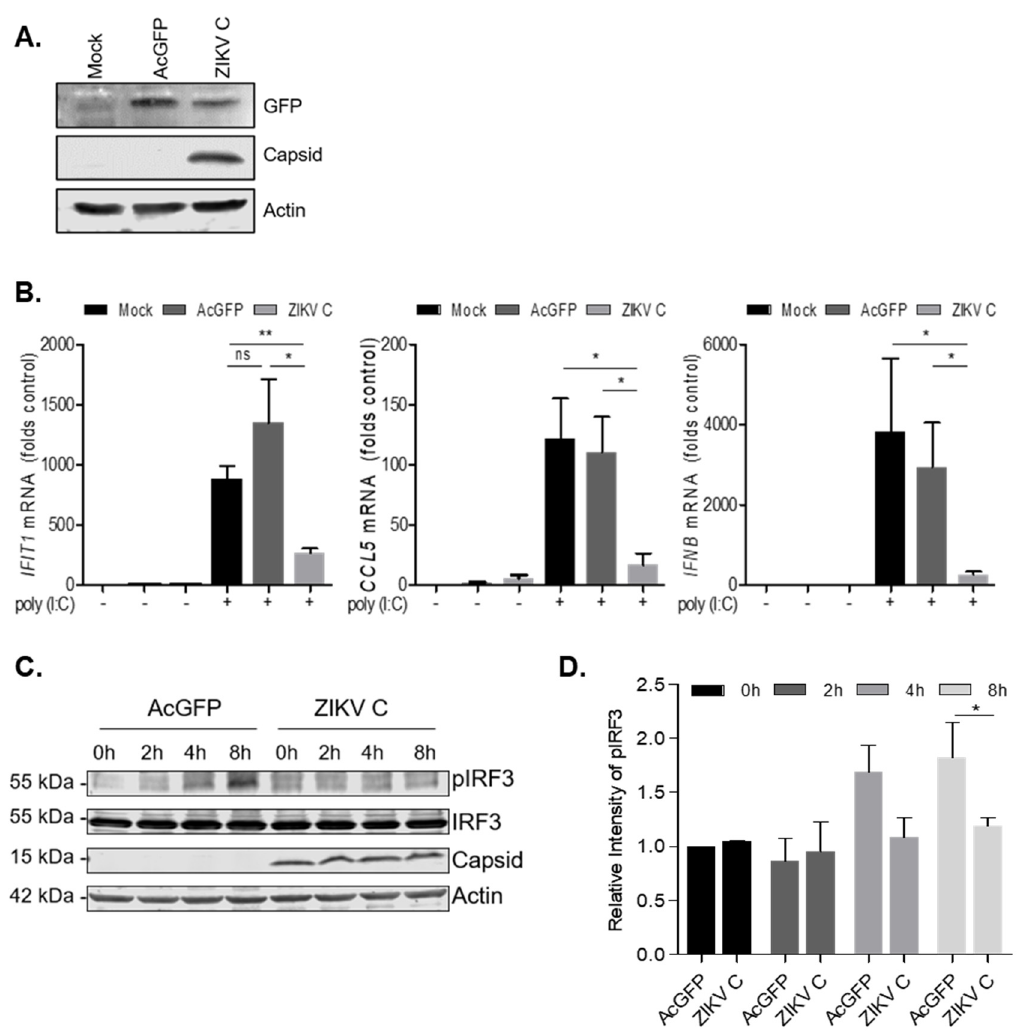
Figure 5. ZIKV capsid-expressing cells suppress IFN induction. ( A ) Immunoblot blot of GFP, ZIKV capsid and actin in cell lysates from AcGFP or AcGFP-ZIKV capsid-expressing stable cell lines. ( B ) Expression of select ISGs in AcGFP and ZIKV C-expressing cells. Cells were transfected with poly (I:C) for 24 h, total RNA was extracted and used to quantify IFIT1, CCL5, IFN- β gene expression by qRT-PCR. Shown are normalized values relative to mock cells (control). Data were from three independent experiments. ( C ) Time course of p-IRF3 in AcGFP or ZIKV C stables following poly (I:C) transfection. Western blot with antibodies that detect pIRF3, IRF3, ZIKV capsid, and actin are shown. ( D ). Mean relative intensity of Western blots based on three independent experiments. Results of statistical analyses ( t -test) are indicated (* p ≤ 0.05) (**, p ≤ 0.01). ns, not significant.